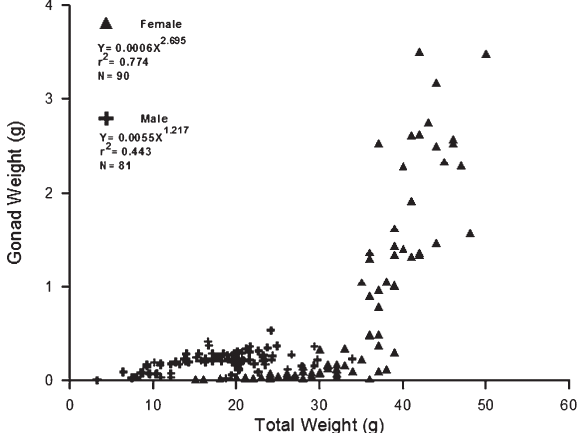
Fig. 6. – Relation between N. caroli male and female gonad weight and total body